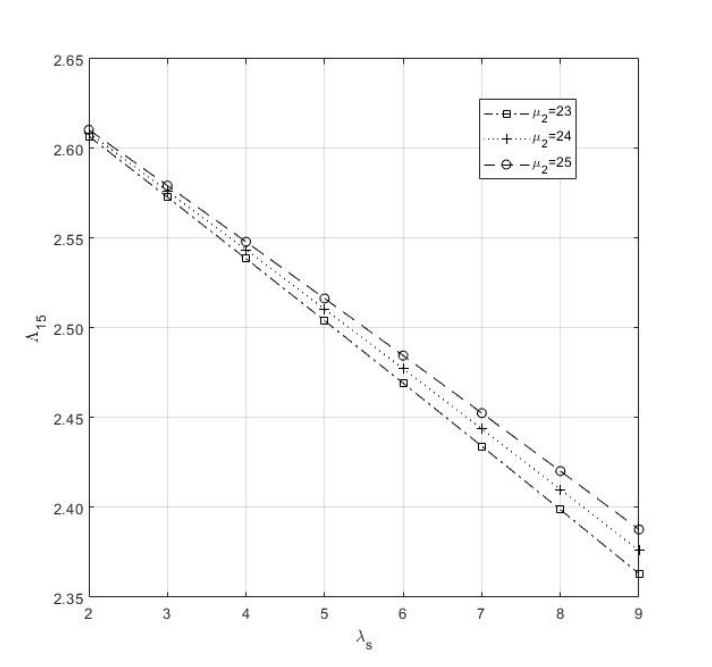
Figure 13. Mean number of Type-II Idle server of µ 2 vs. λ